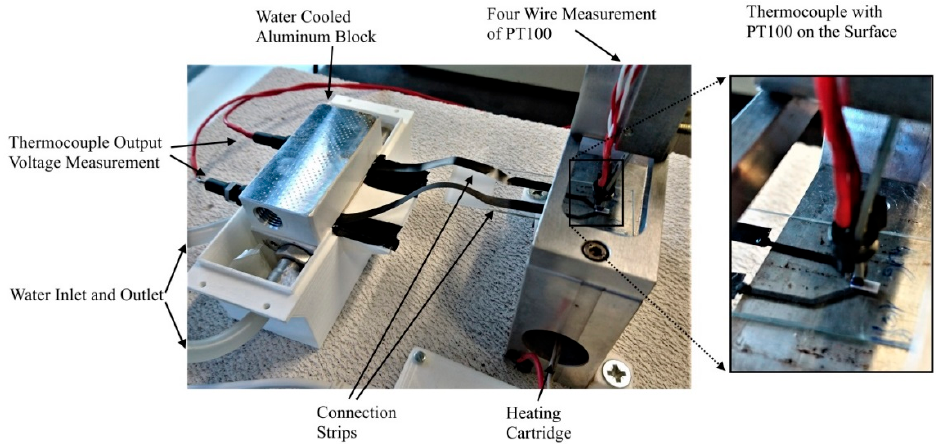
Figure 4. Measurement setup for characterizing the thermocouples. A thermocouple was placed on a metallic block that was heated from the inside by a heating cartridge. A PT100 thermistor was attached to the surface of the thermocouple junction and read out by four-wire measurement using a digital multimeter. The connections of the thermocouple were placed inside a water-cooled aluminum block and connected to a digital multimeter to measure the thermocouple output voltage.